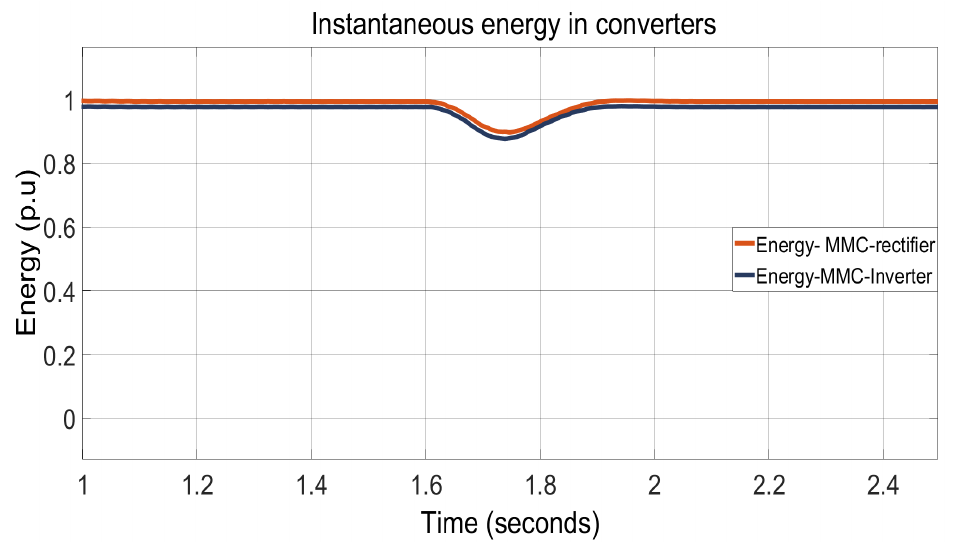
Figure 21. Instantaneous energy in the MMC-rectifier and the